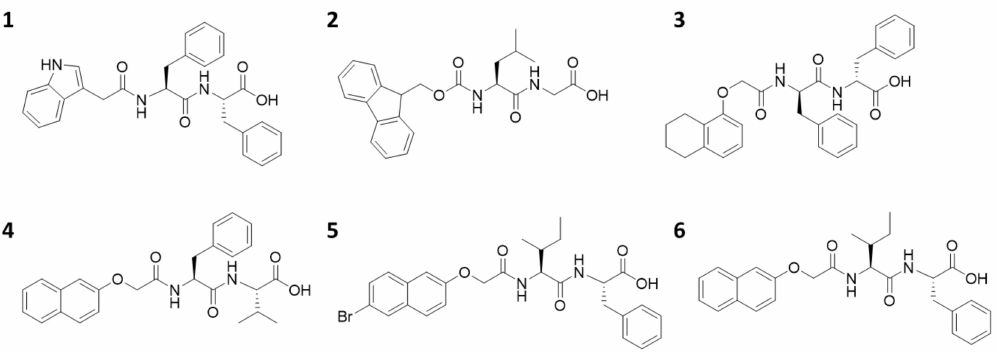
Figure 1. The chemical structures of the gelators used here, 1 – 6 .